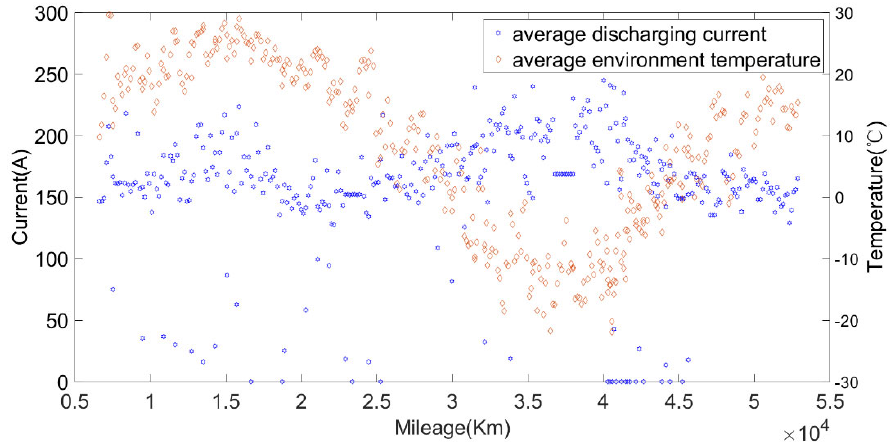
Figure 18. The relationship between the discharging current, average environmental temperature and mileage.